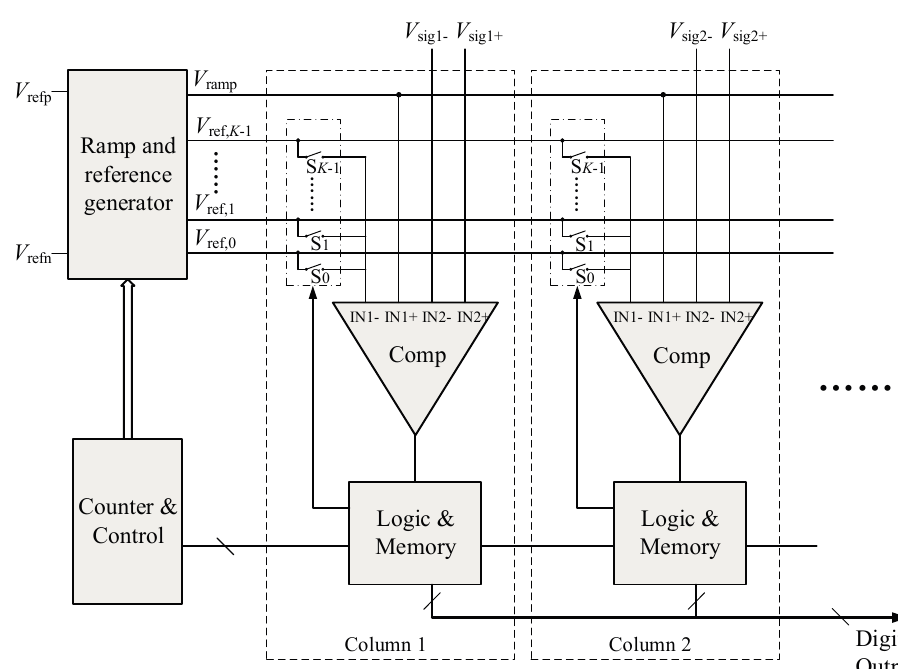
Figure 1. Block diagram of the proposed two-step SS ADC.